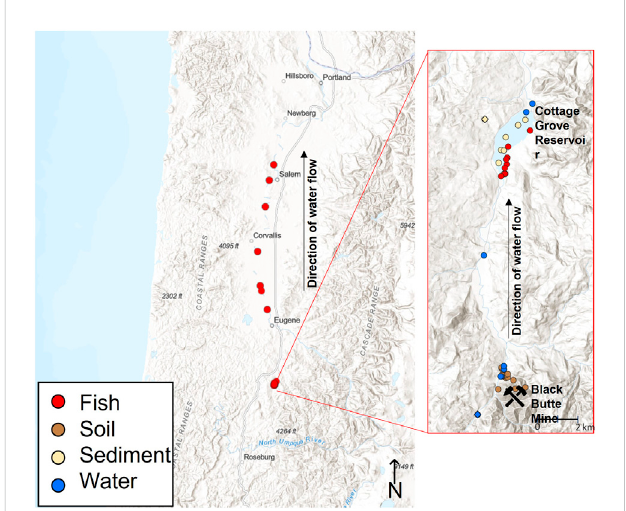
Map showing locations where samples were collected. Fish were collected overalarger geographic areathan theabioticparameters(soil, sediment, and water). Colors denote collection locations of different matrices. Circles represent locations downstream of the mine and diamonds represent background